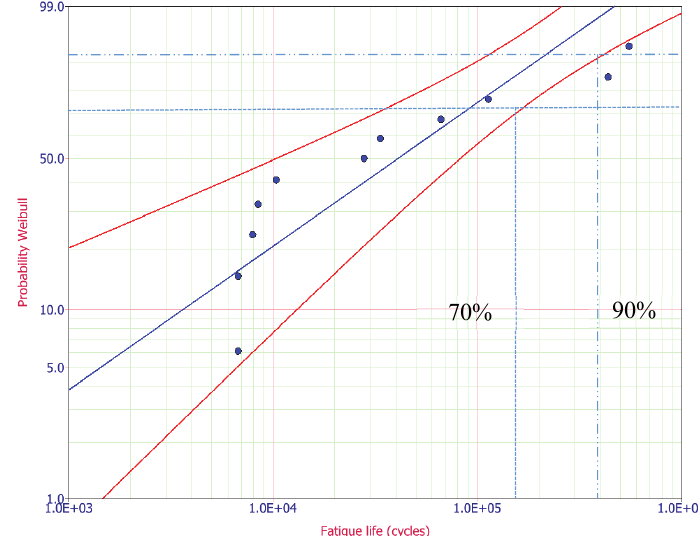
Figure 9: The Weibull probability distribution plots of fatigue damage for